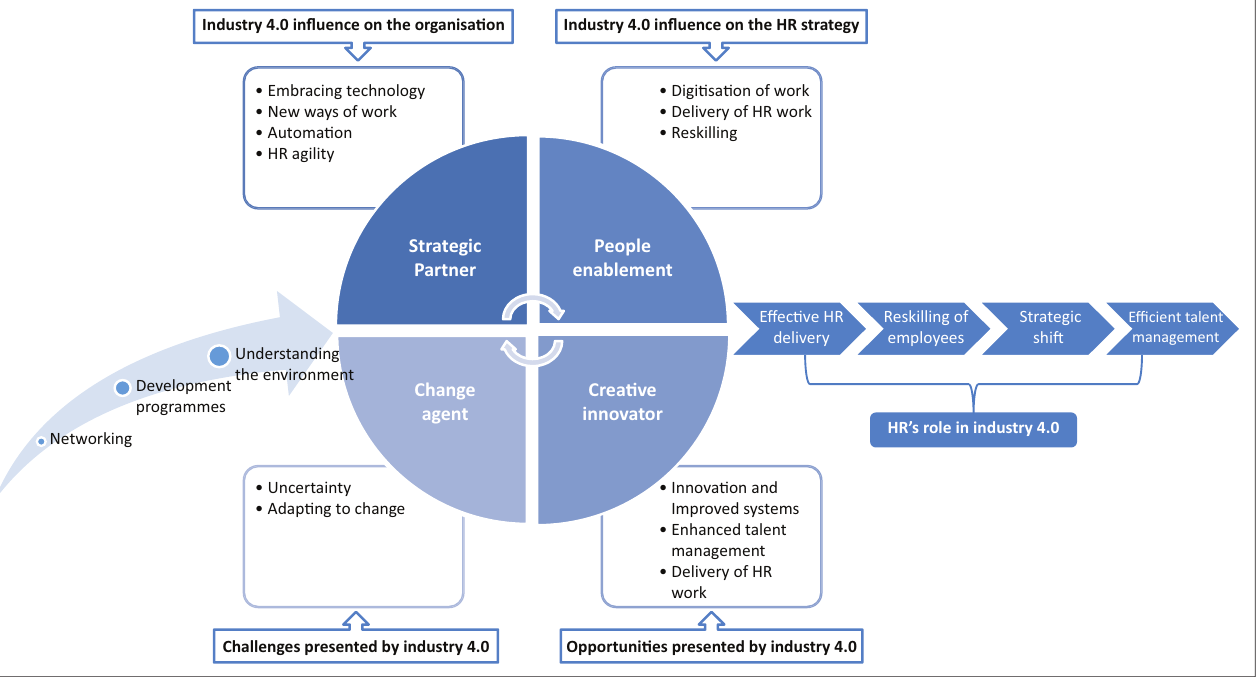
FIGURE 1: A holistic model for navigating industry 4.0 for human resource